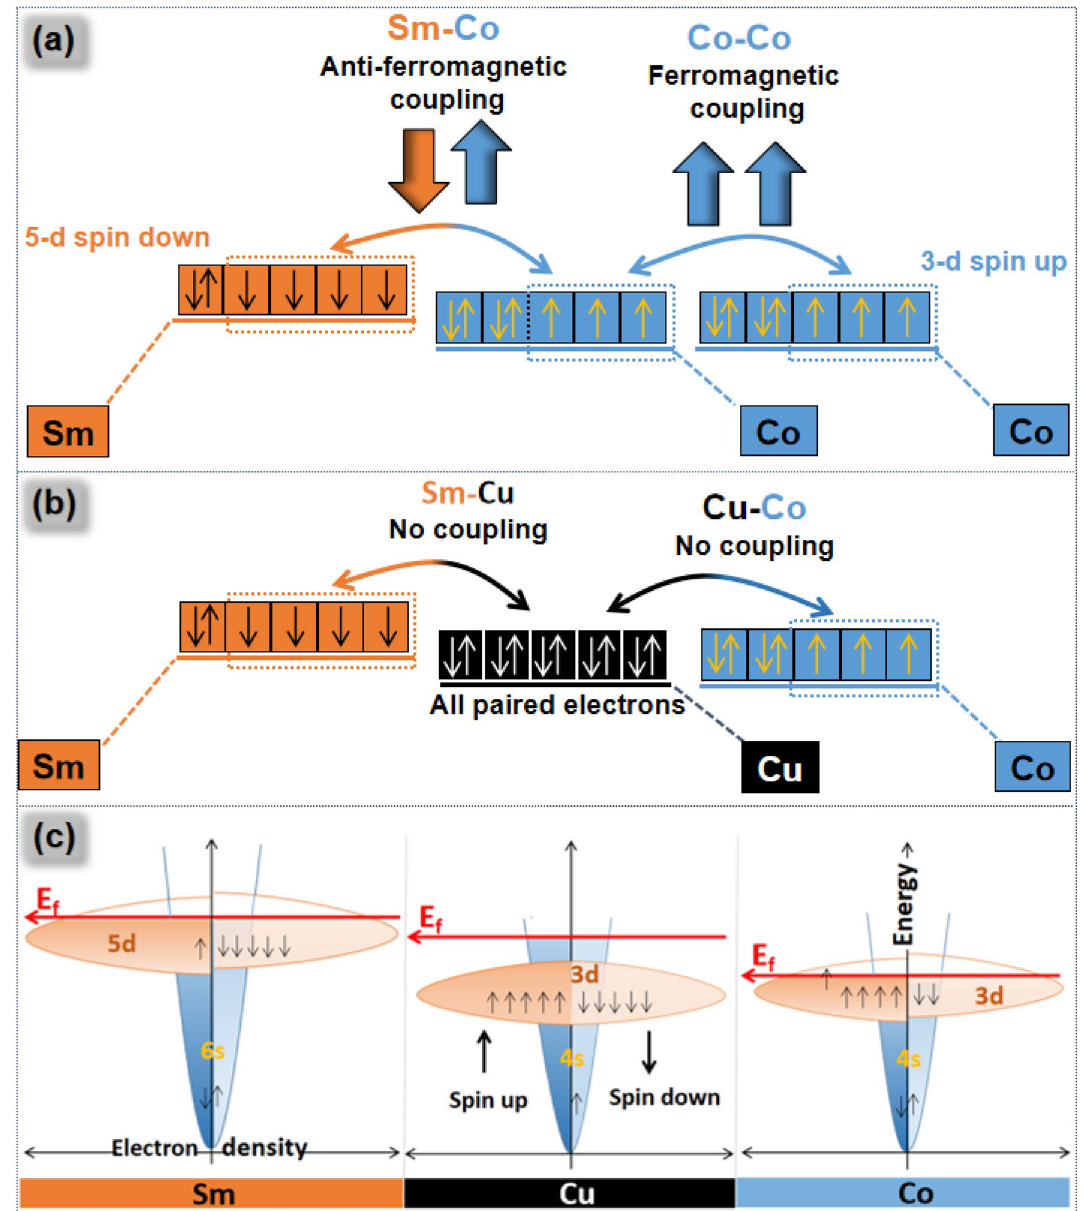
Figure 5. ( a , b ) Schematic illustration of exchange coupling between the electrons of Sm, Co and Cu, ( c ) rigid band model of Sm, Co and